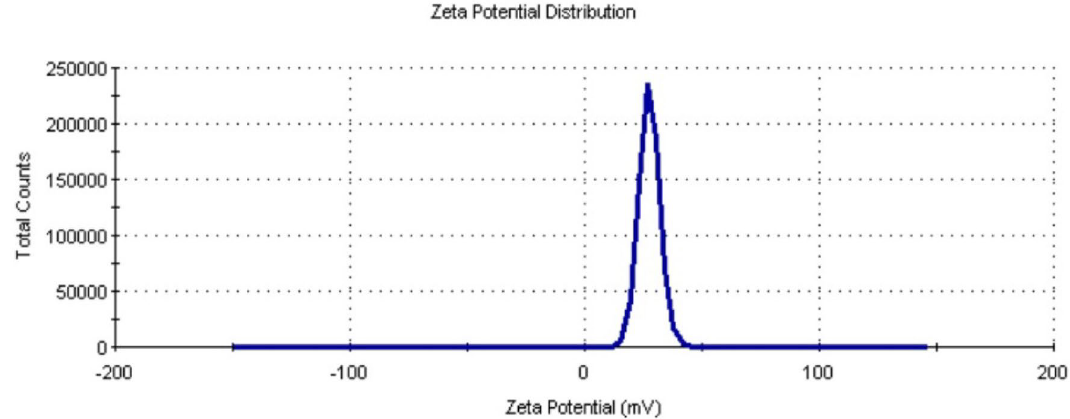
Figure 8. Zeta potential of Alk-ZnO NPs dispersed in water.